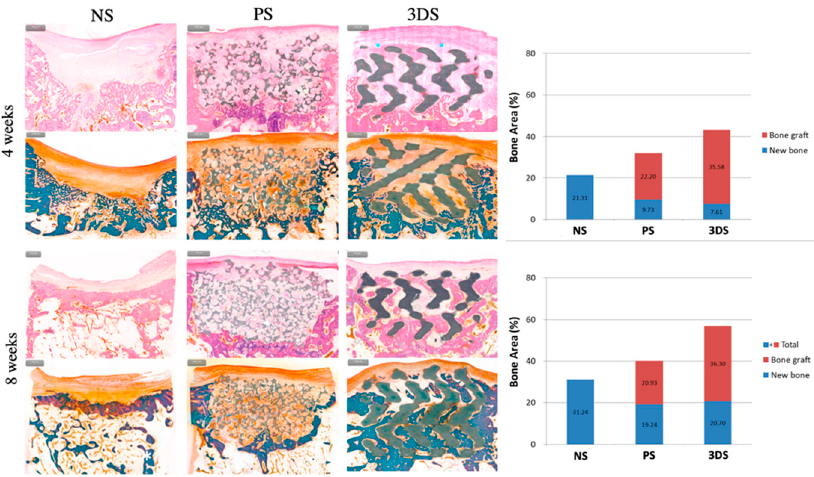
Figure 5. Histomorphometric evaluation at 4 and 8 weeks.